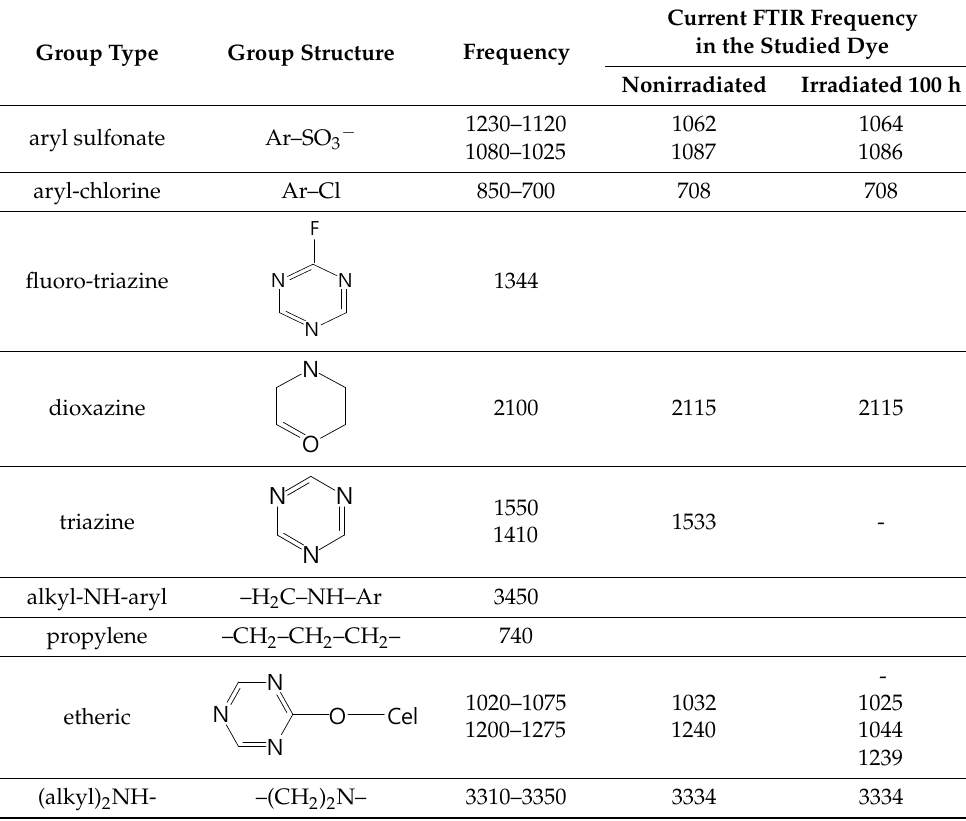
Table 5. FTIR frequency characteristics of the most important groups and their existing frequencies in the dye molecule RB_204.